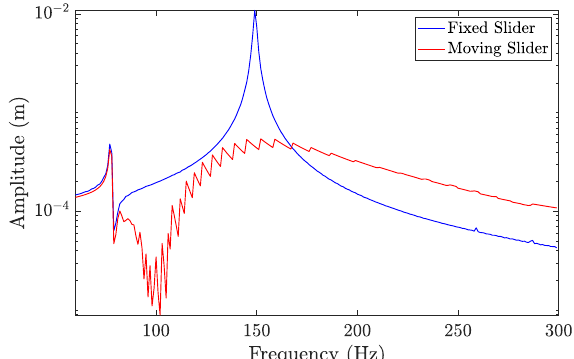
Figure 11. FRF comparison between the self-tuning resonator and the fixed resonator at 0.5 s / a r